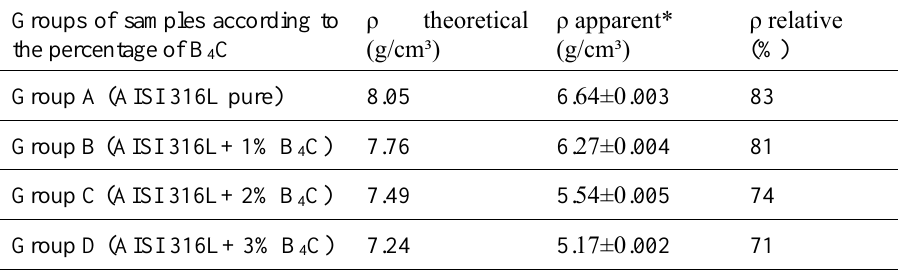
Table 3. Green densification of the